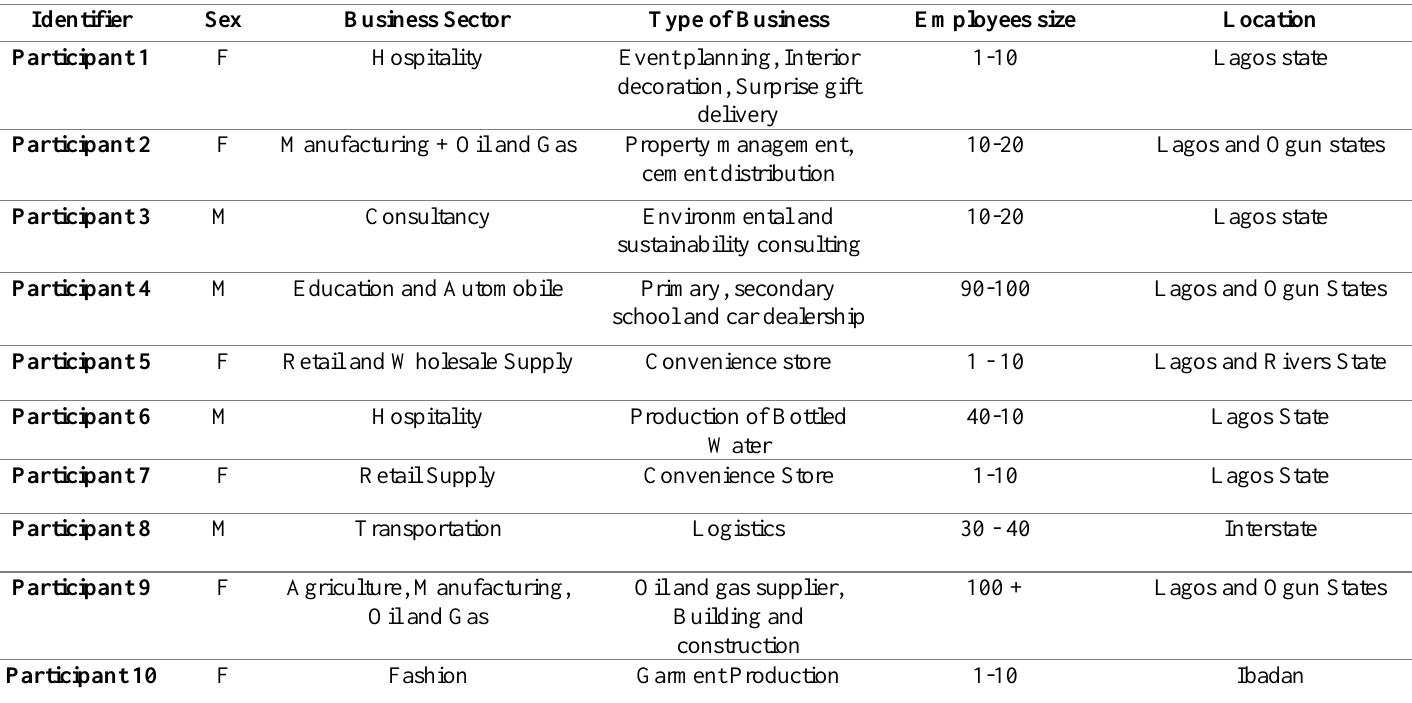
Table 1: Overview of interviewed